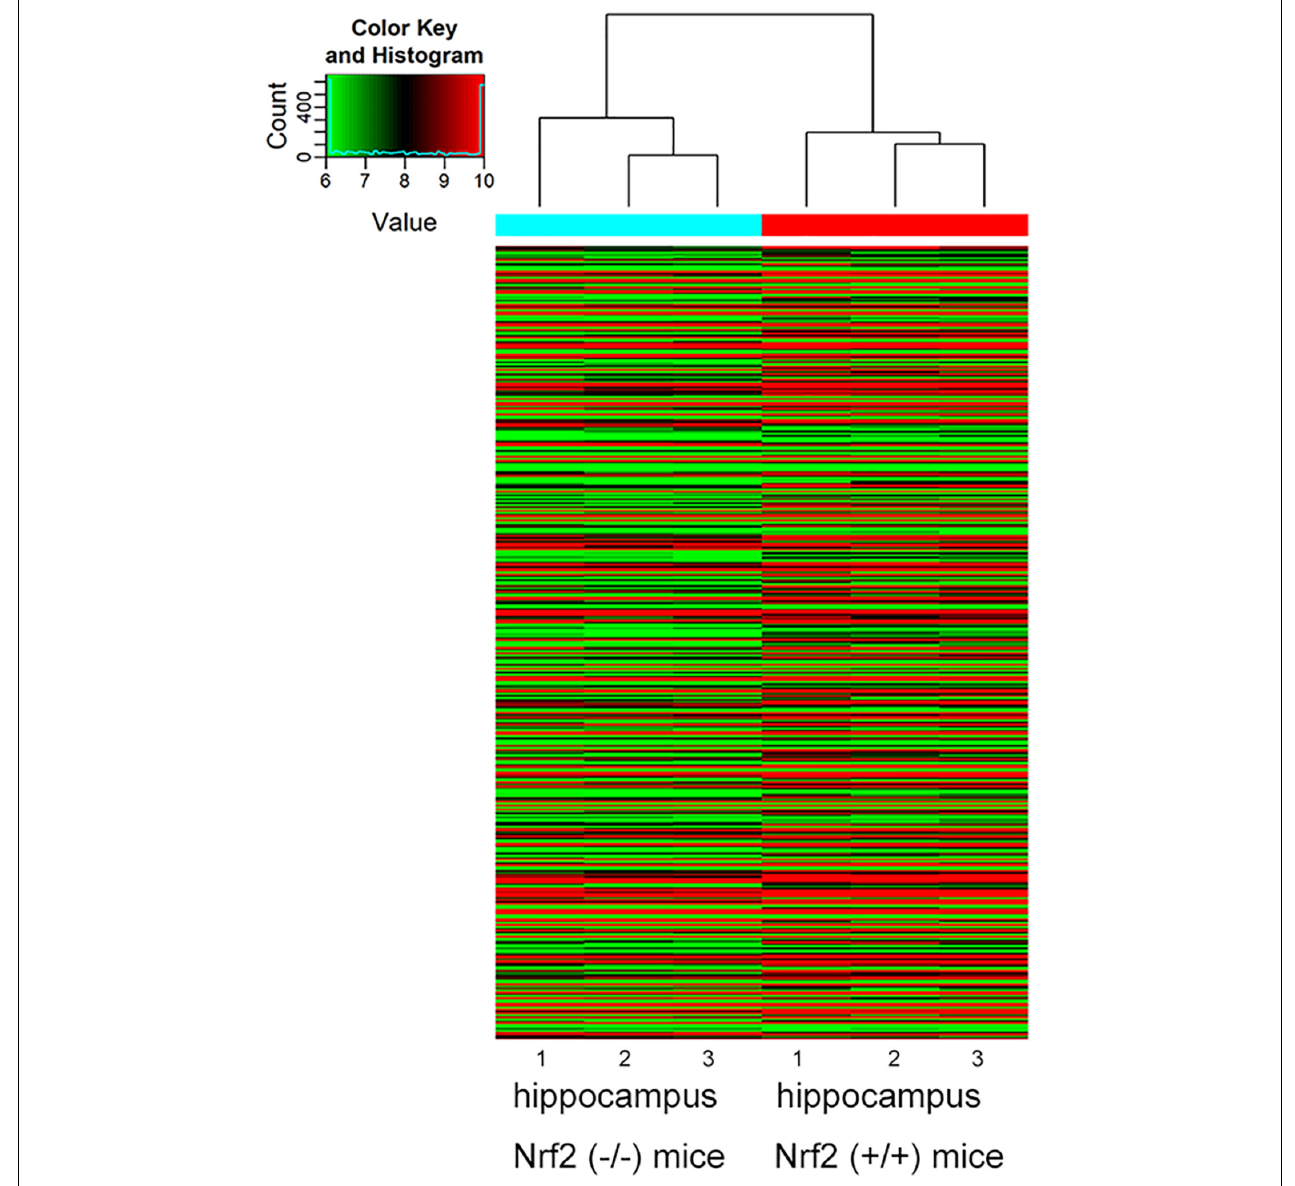
FIGURE 1 | Hierarchical clustering analysis based on the expression profile of the DEmRNAs in the Nrf2 (–/–) hippocampus. n = 3.